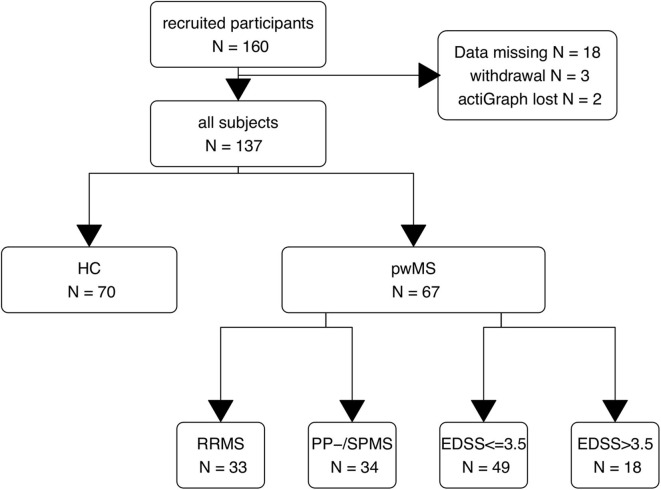
Study flow chart. HC, healthy controls; pwMS, patients with MS; RR, relapsing–remitting MS; PP-/SPMS, primary and secondary progressive MS; EDSS, expanded disability status scale (EDSS > 3 indicates walking impairment).